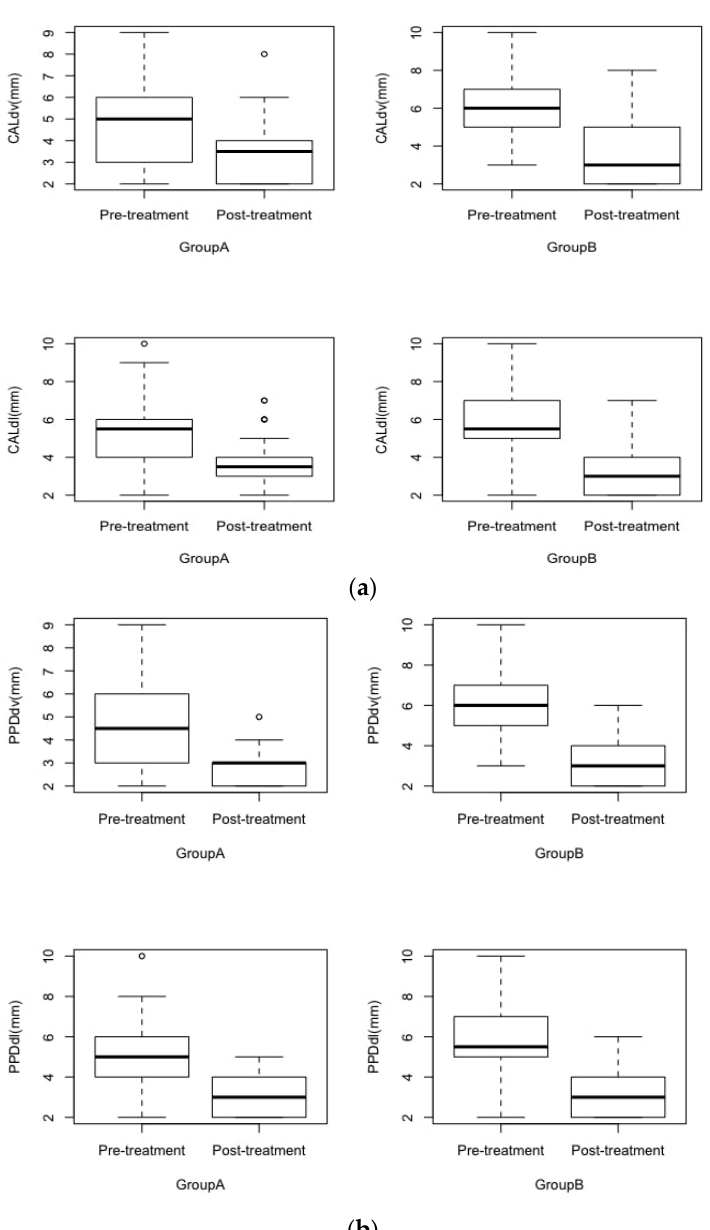
Figure 2. Periodontal values at baseline and 6 months after third molar extraction in Group A (envelope flap) and Group B (triangular flap). ( a ) CAL in groups A and B, before and after extraction at the distovestibular and distolingual points. Box plot: median, upper quartile, lower quartile, upper extreme, lower extreme. CALdv = CAL measurement at the disto-vestibular aspect of teeth; CALdl = CAL measurement at the disto-lingual aspect of teeth. ( b ) PPD in groups A and B, before and after extraction at the distovestibular and distolingual points. Box plots: median, upper quartile, lower quartile, upper extreme, lower extreme. PPDdv = PPD measurement at the disto-vestibular aspect of teeth; PPDdl = PPD measurement at the disto-lingual aspect of teeth.